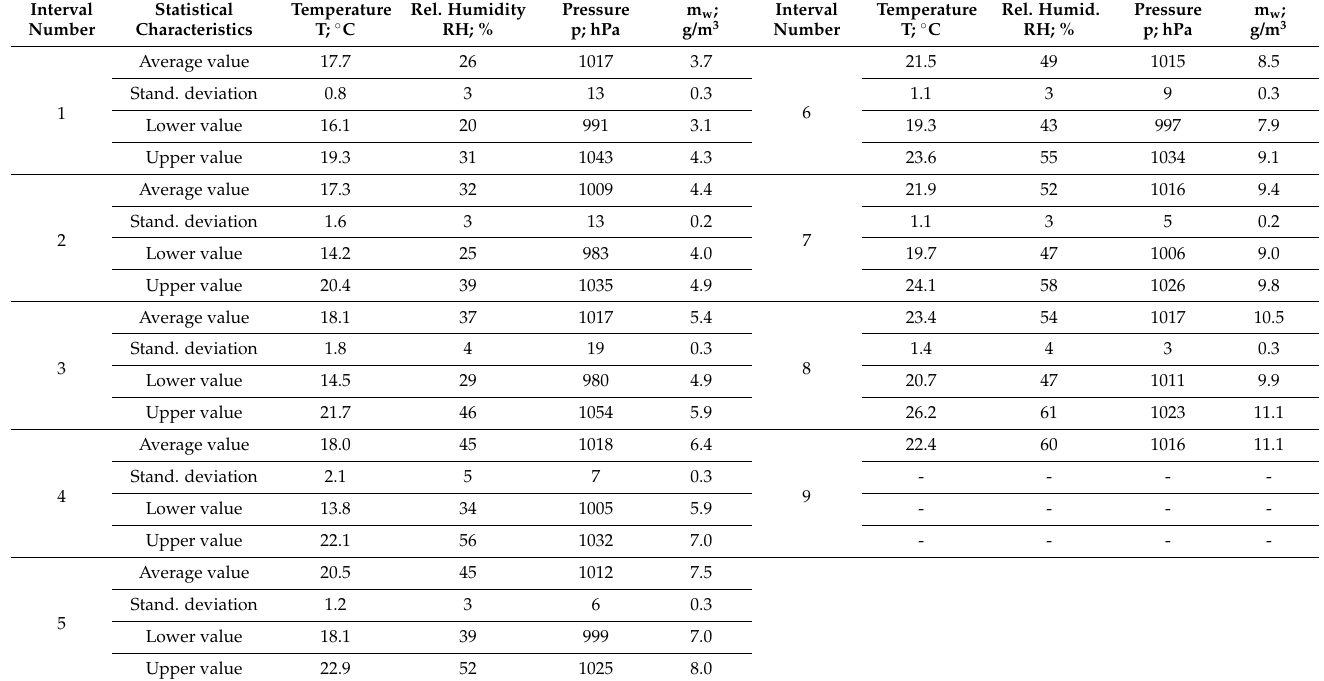
Table 4. The statistical characteristics of atmospheric parameters in the 9 intervals of water vapour mass in air m w (short